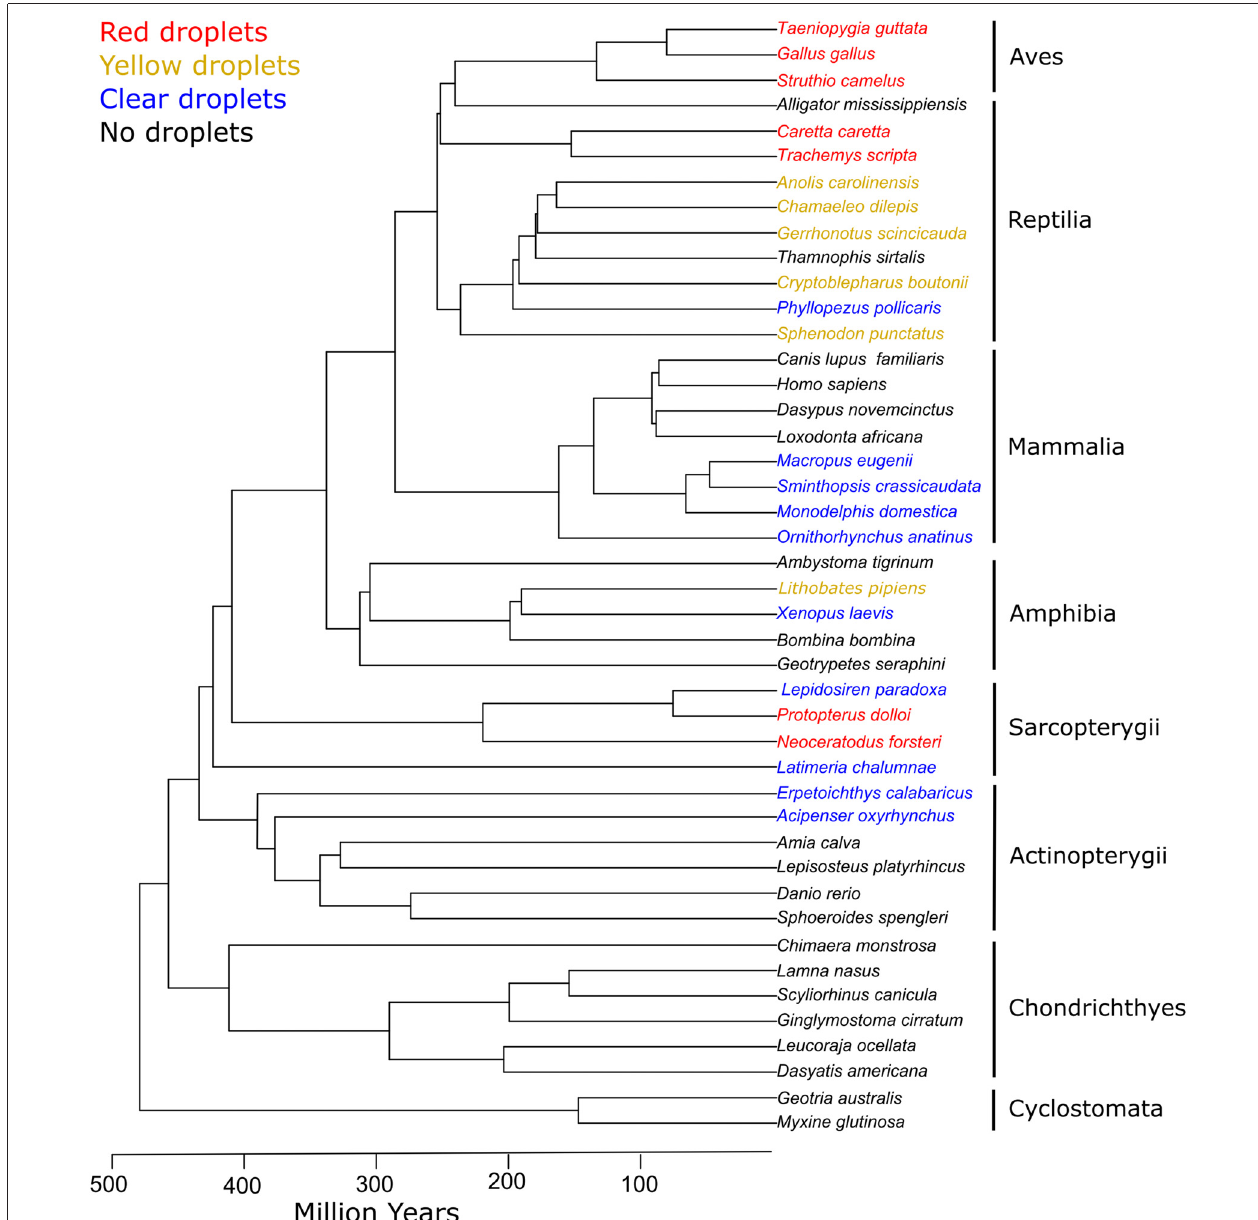
FIGURE 6 | Cone oil droplets are widely distributed among vertebrate clades. The presence of cone oil droplets in each species is indicated by the color of the branch tip label. Black indicates that oil droplets are not present in that species. Blue indicates the presence of colorless oil droplets only. Yellow indicates the presence of yellow and colorless droplets. Red denotes the presence of red, yellow, and colorless droplets (except for Sarcopterygii which lack yellow droplets). Tree topology and timescales are based on Irisarri et al. (2017).